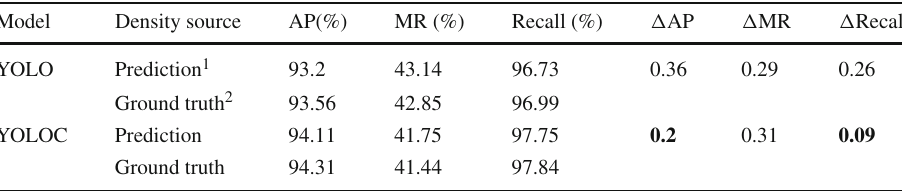
Table 2 Ablation studies on density prediction